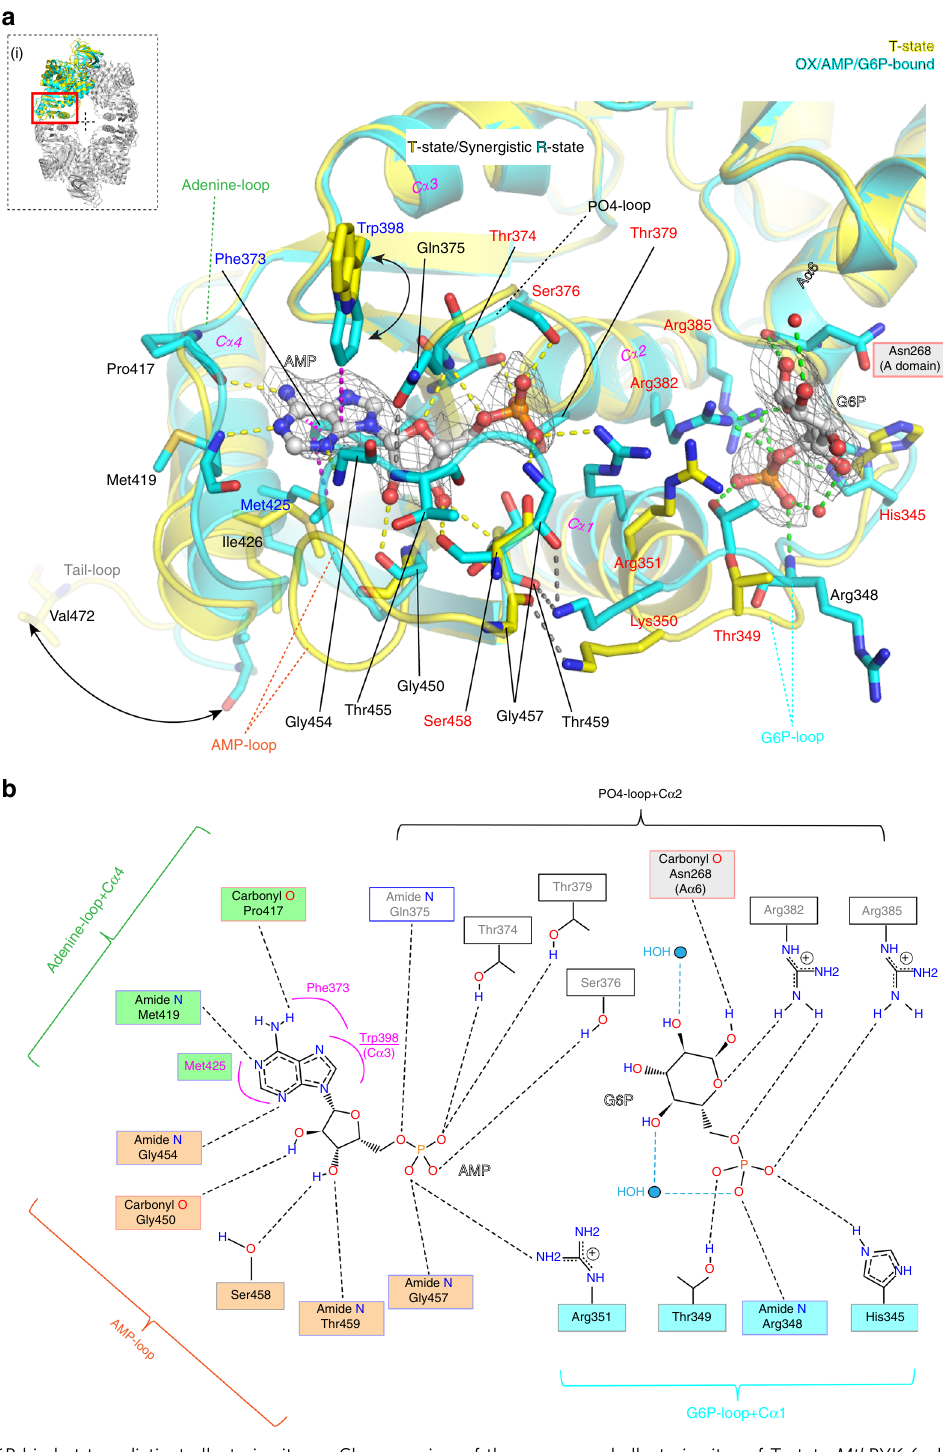
Fig. 3 AMP and G6P bind at two distinct allosteric sites. a Close-up view of the superposed allosteric sites of T-state Mtb PYK (yellow) and R-state Mtb PYK-OX/AMP/G6P (cyan). The polypeptide chain is shown as a cartoon while interacting residues are shown as sticks. Allosteric effectors AMP and G6P are shown with an unbiased Fo – Fc electron-density map contoured at 3.0 σ (grey). Water molecules are shown as red spheres. Interactions between ligands and the R-state structure are indicated by dashed lines. The T-shaped stacking (or CH – π hydrogen bonding) interactions formed between the adenine ring of AMP and Mtb PYK residues (Phe373, Trp398, Met425) are shown by pink dashed lines. Secondary structures that are involved in the interactions with effectors are indicated. The conformational changes of the C-terminal tail loop and the side-chain of residue Trp398 are indicated by arrows. The location of the allosteric site within a subunit is shown as a red box in the inset (i). b , Schematic drawing showing the synergistic interactions at the Mtb PYK allosteric sites. Residues forming T-shaped stacking (or CH – π hydrogen bonding) interactions with the adenine ring of AMP are indicated in pink, while water molecules are shown as blue